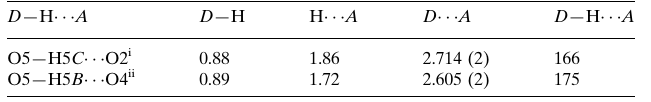
Hydrogen-bond geometry (A˚ , (cid:1)